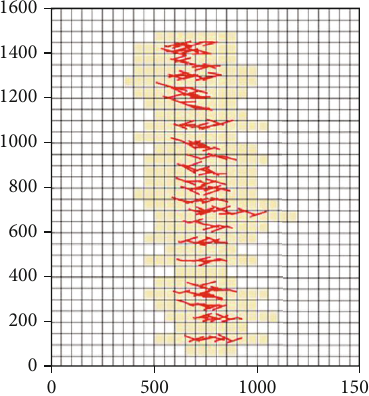
Figure 12: Historical fi tting results of the reconstruction